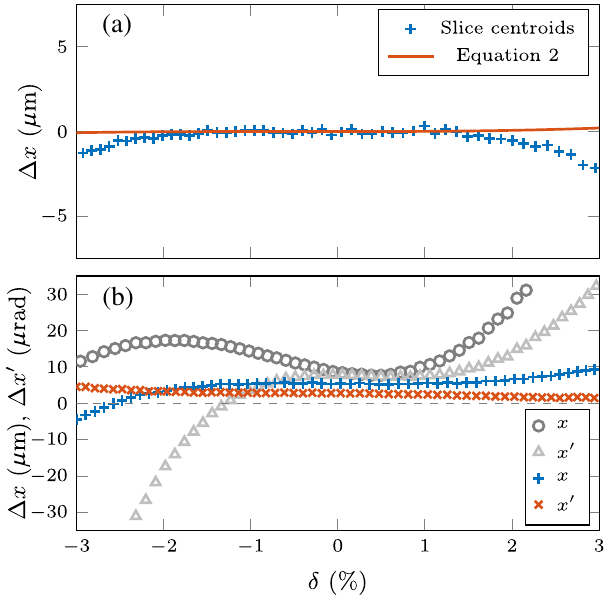
FIG. 5. (a) Horizontal offset of the beam after the third-order achromatic BC as a function of δ . The blue marks show the slice spatial centroids of a tracked beam and the red line is Eq. (2), using the corresponding matrix elements. Note the large differ- ence in scale compared to Fig. 2. (b) Horizontal slice spatial and angular centroids after tracking through the lattices in Fig. 3 (gray circles and triangles) and Fig. 4 (colored crosses), with CSR